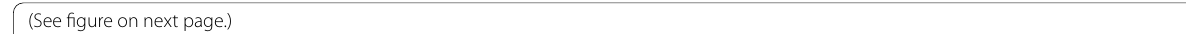
figure on next Fig. 3 Electron micrographs showing the entry of ROLPs into the intestinal epithelium of R. dorsalis . a Intestinal epithelium, showing microvilli on the lumen side and basal lamina covered with muscle fibers and serosal barrier on the hemocoel side. b ROLP distribution in the gut lumen. ROLP-infected intestines were incubated with Imp-specific antibody and then with 15-nm gold particle-conjugated goat antibody against rabbit IgG as secondary antibody. c – j Process for entry of ROLPs from the gut lumen into epithelial cells by successively passing through the perimicrovillar membrane ( c – e ), microvilli ( f , g ), and apical plasmalemma ( h – j ). Arrows indicate ROLPs. AP, apical plasmalemma; EC, epithelial cell; GL, gut lumen; MV, microvilli; PM, perimicrovillar membrane; SB, serosal barrier. Black arrows indicate gold particles. Red arrows indicate ROLPs. Scale bars, 2 μm ( a ) and 200 nm ( b – j